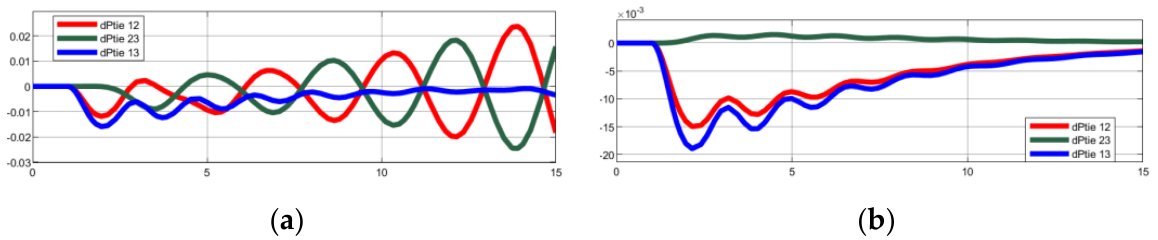
Figure 13. ( a ) Tie-Line Power Deviations, Case 3. ( b ) Tie-Line Power Deviations: Case 4.